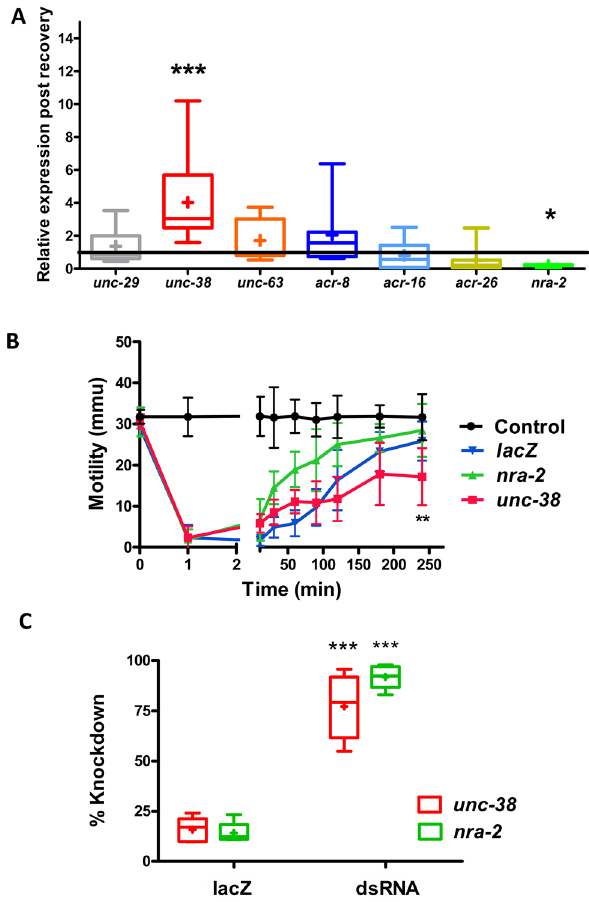
Figure 6. unc-38 and nra-2 transcript levels altered during levamisole recovery and nra-2 knockdown results in faster recovery in adult female B. malayi. ( A ) Transcript level analysis on recovered worms after being incubated in levamisole for 4 h. unc-38 was significantly upregulated while nra-2 was significantly downregulated (Student’s t-test; ***p < 0.0005, *p < 0.05) whereas the other transcripts tested, unc-29, unc-63, acr-8, acr-16 and acr-26 were unaltered. N = 12. ( B ) Knockdown of nra-2 using dsRNA significantly increases the rate of recovery (Two-way ANOVA; p < 0.05), whereas knockdown of unc-38 transcript resulted in the worms not completely recovering after 4 h (Student’s t-test; p < 0.005). lacZ dsRNA was used as non-specific control and control worms were soaked in water. ( C ) Knockdown of unc-38 and nra-2 transcripts after 4 days of incubation in dsRNA assayed using qPCR. Knockdown in the unc-38 transcript was 77.27 ± 7.21% and nra-2 was 91.97 ± 2.57%). The knockdown of these transcripts in worms soaked in non-specific lacZ control was: unc-38— 15.87 ± 2.69%; and nra-2— 14.23 ± 2.32%. N = 5 worms over two biological replicate